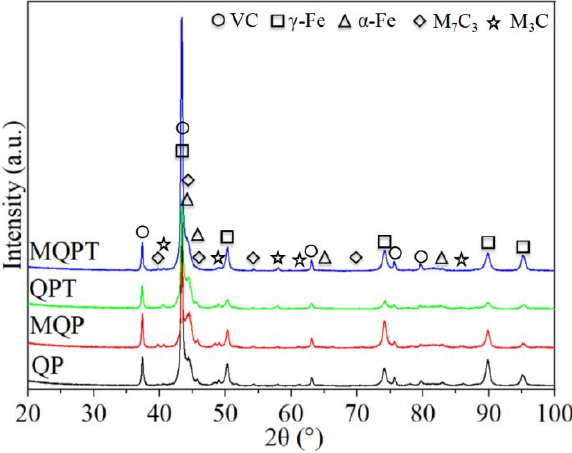
Figure 3. XRD patterns of the VCFC with different heat-treated process.